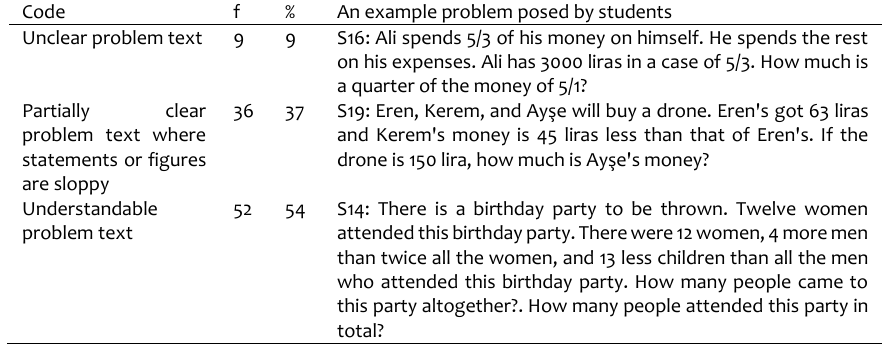
Table 3. Examination results of the problems in terms of written language